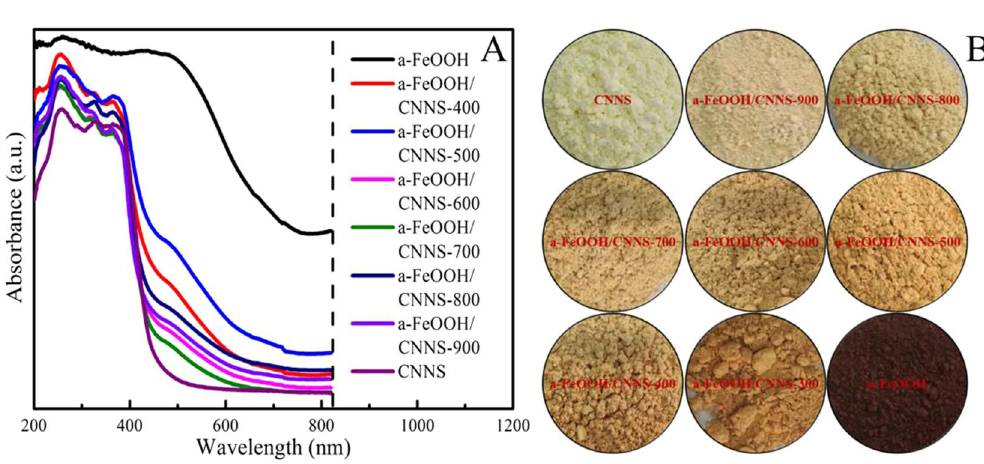
Figure 5. ( A ) UV-vis diffuse reflectance spectra and ( B ) digital photographs of CNNS, a-FeOOH and a-FeOOH/CNNS